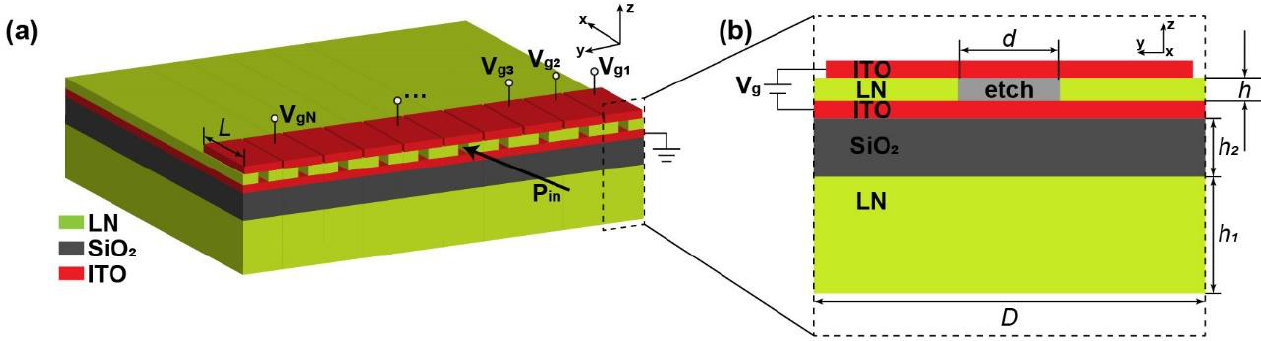
Figure 1. Schematic of the on-chip metasurface device. ( a ) Schematic of the three-dimensional structure of the on-chip metasurface device. The TE wave of wavelength λ = 1550 nm travels in the positive x direction (polarized in the y direction); ( b ) Schematic cross section of the device unit structure. The terms h = 0.5 µ m, h 1 = 2 µ m and h 2 = 1 µ m denote the thickness of the upper LN layer, lower LN layer, and silicon dioxide layer of LNOI, respectively. The cuboid slits etched in the upper LN layer are in the middle of the unit with a width of d = 70 nm.